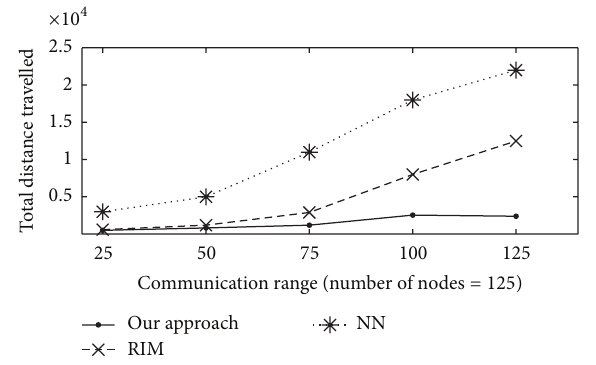
Figure 5: Total number of packets exchanged versus communica- tion range (meters) for 25 to 125 nodes in the